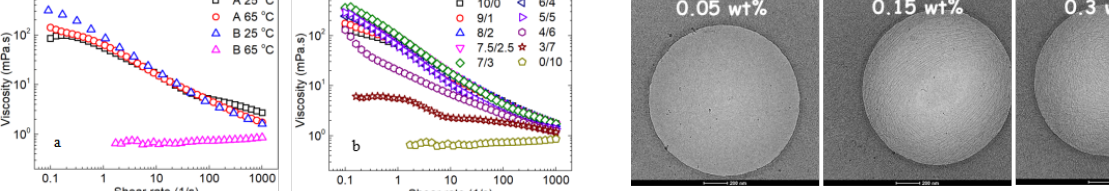
hydroxypropyl sulfobetaine and tetradecyl propyl sulfobe- taine have synergistic effect in terms of viscosity increasing.